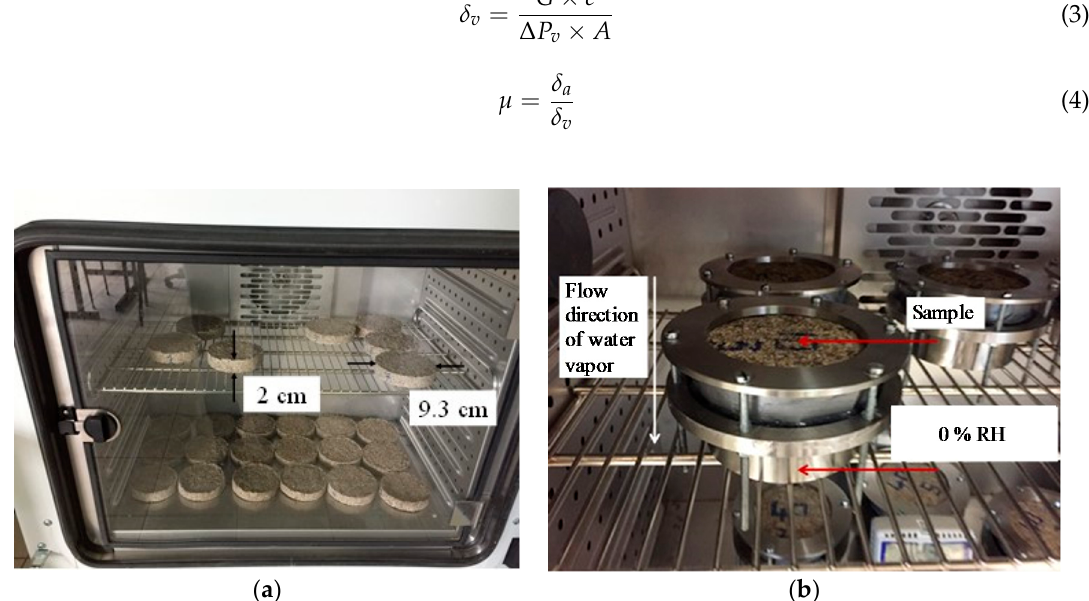
Figure 8. ( a ) Samples in climatic chamber at 50 °C and 10% RH; ( b ) dry cup method for vapor permeability measurements . permeability